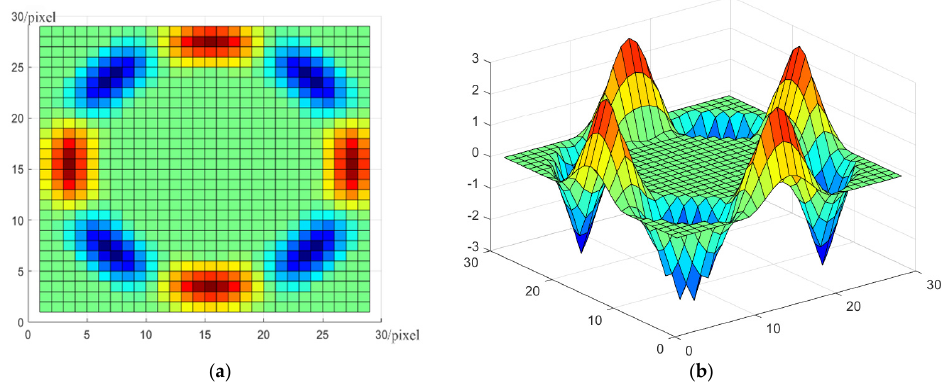
Figure 4. The real part of the constructed convolution kernel. ( a ) The planar schematic; ( b ) the three-dimensional schematics.